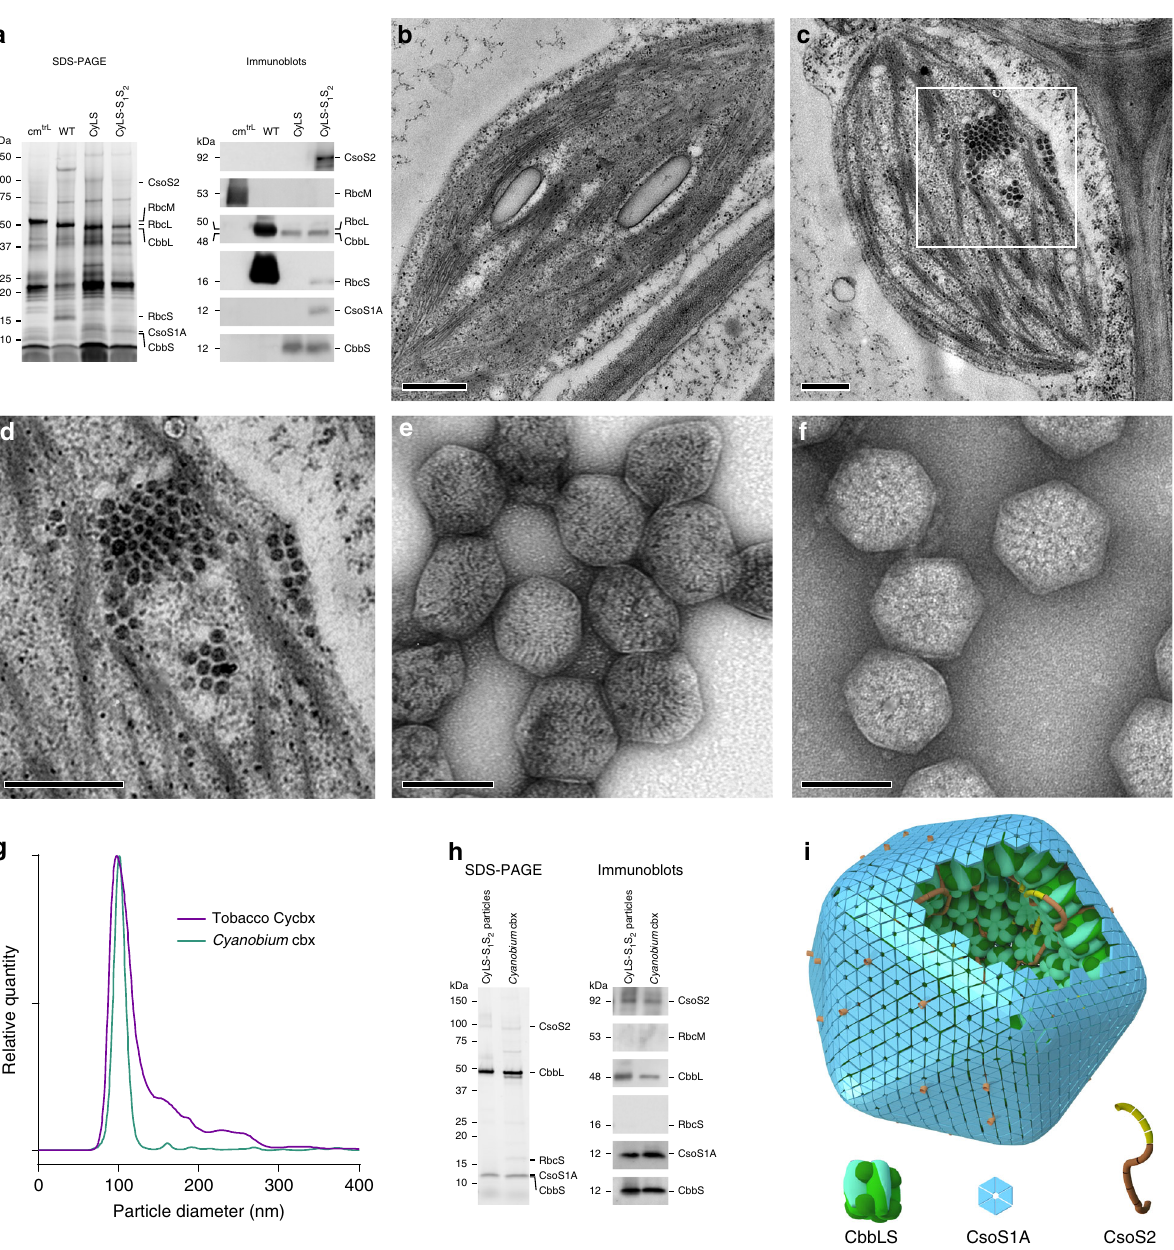
Fig. 3 Carboxysomes are synthesized in tobacco chloroplasts from four proteins. a SDS-PAGE and immunoblots of Rubisco and carboxysomal proteins expressed in leaves of the recipient plant line (cm trL ), wild-type tobacco (WT) and the transformant lines CyLS and CyLS-S 1 S 2 . b Transmission electron micrographs (TEM) of chloroplasts from tobacco expressing Cyanobium Rubisco (CyLS plants) and tobacco expressing Cyanobium Rubisco along with the shell proteins CsoS1A and CsoS2 (CyLS-S 1 S 2 plants) ( c ), showing aggregations of electron-dense particles of approximately 100 nm. The inset in c at higher magni fi cation ( d ). Scale bars 500 nm for images b – d . Negatively stained carboxysomes puri fi ed from CyLS-S 1 S 2 plants ( e ) and carboxysomes puri fi ed from Cyanobium cyanobacterial cells ( f ). Scale bars for puri fi ed carboxysomes 100 nm. g Diameters of carboxysomes from wild-type Cyanobium cells (cyan line) and carboxysomes puri fi ed from CyLS-S 1 S 2 plants (magenta line) determined using a Nanosight particle analyser. h SDS-PAGE and immunoblots of proteins in particles isolated from CyLS-S 1 S 2 leaves and genuine carboxysomes from cultured Cyanobium cells ( Cyanobium cbx). i A model of the carboxysome structures produced in transgenic CyLS-S 1 S 2 plant chloroplasts indicating the four protein components required to generate the structure. Comparison can be made with the complete wild-type structural model presented in Fig. 1c in which the pentameric vertex proteins (CsoS4AB), ancillary shell proteins (CsoS1D and CsoS1E) and carbonic anhydrase (CsoSCA) are Rubisco and plant CO 2 assimilation characteristics of trans- previously reported for the Cyanobium enzyme (Table 2 and formed plants. Analysis of Rubisco catalytic performance in ref. 18 ). Both CyLS and CyLS-S 1 S 2 plants demonstrated auto- trophic growth at 2% ( v / v ) CO 2 (Fig. 5). Both transgenic plant clari fi ed leaf extracts of CyLS and CyLS-S 1 S 2 plants revealed an enzyme with high catalytic turnover rate ( k cat ) and types contained similar quantities of Rubisco but ten-fold less Michaelis – Menten constant for CO 2 ( K C ), consistent with values than wild-type tobacco (Table 2). For CyLS plants, leaf